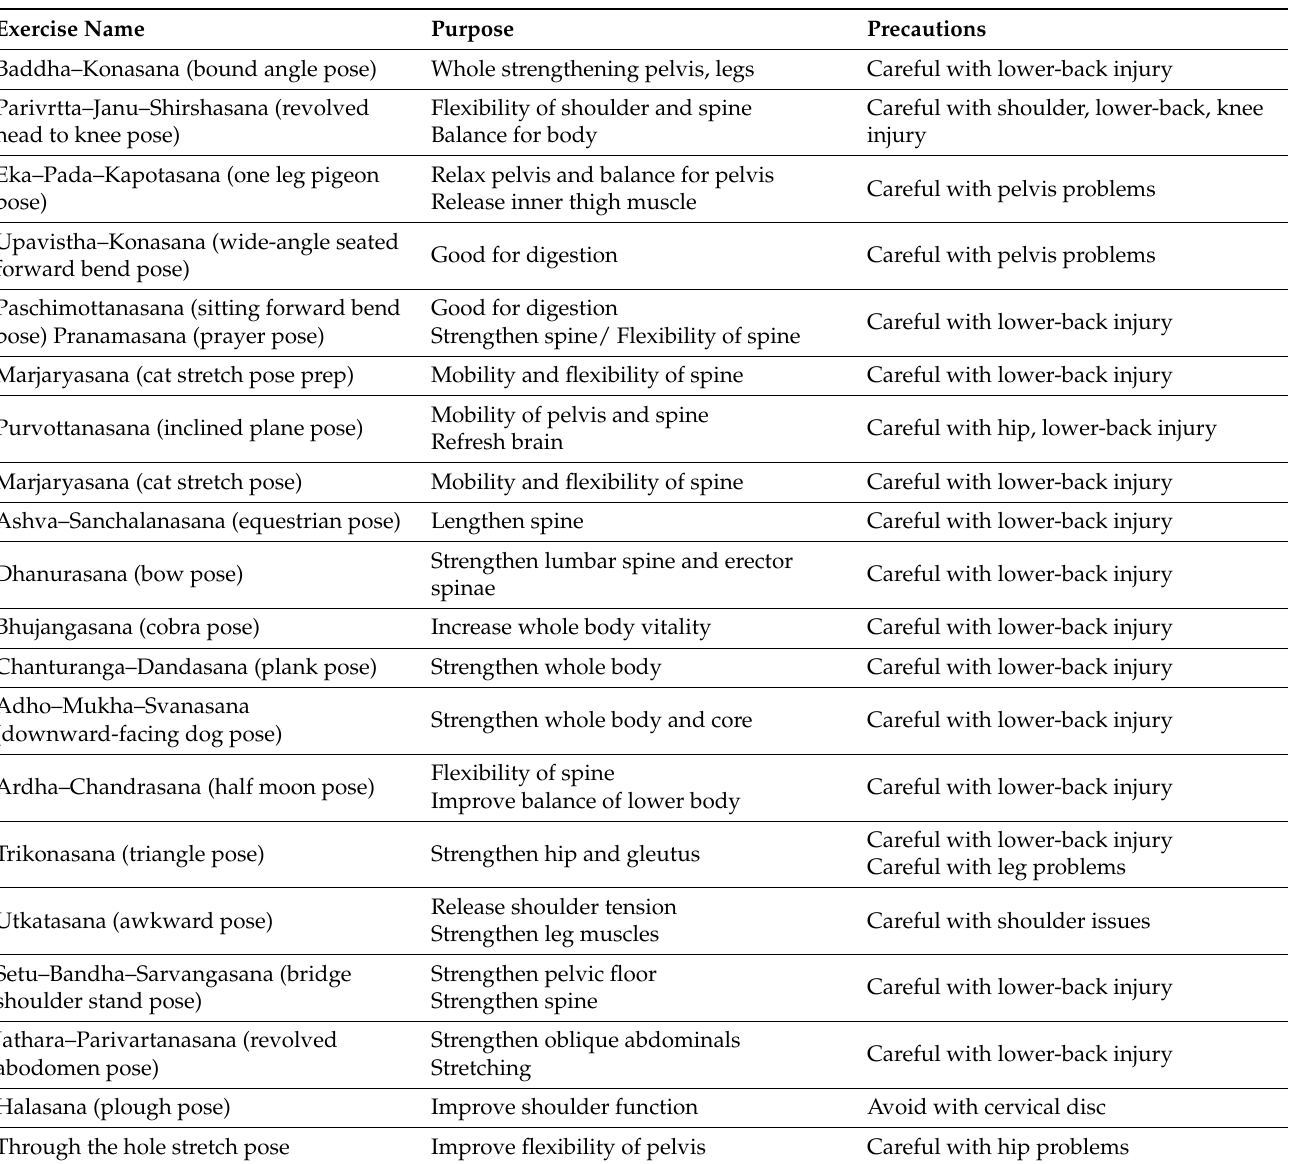
Table A2. The yoga exercise purpose and